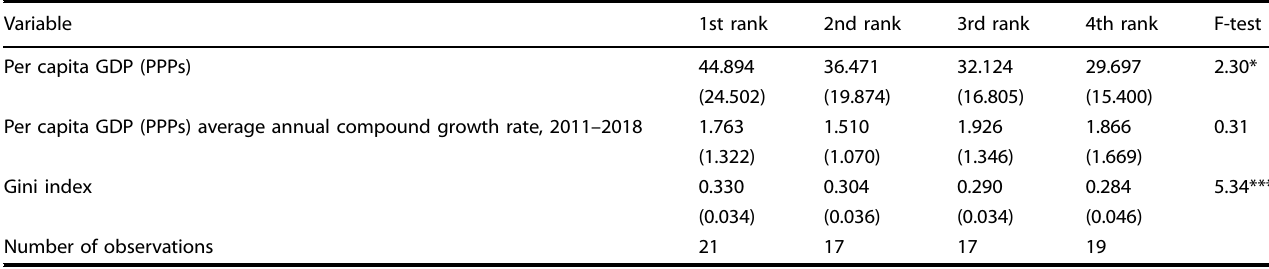
Table 1. ANOVA on indicators of economic performance and inequality across cities of different rank.